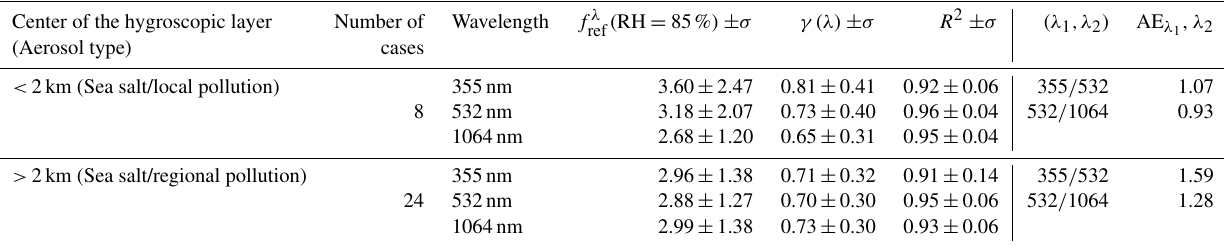
Figure 5. Particle backscatter coefficient enhancement factors with RH ref = 40% at 355, 532, and 1064nm. (a) Spectral Hänel fits for the cases below 2km at 355, 532, and 1064nm; (b) individual f 355 and mean Hänel fit; (c) individual f 532 and mean Hänel fit; (d) individual ref ref f 1064 and mean Hänel fit; (e–h) same as (a–d) for the cases above 2km. The shaded areas around the mean Hänel fits represent the standard ref deviation of all individual fits. at RH = 85% and RH ref = 40%. Mean and standard deviation ( σ ) of γ ( λ ) and the correlation Table 2. Spectral enhancement factor f λ ref coefficient, R 2 . Results are given separately for hygroscopic layers (the layers where hygroscopic growth was calculated) below and above 2km. The layer-mean Ångström exponent between the pairs (355, 532nm) and (532, 1064nm) is reported in the last two columns. Center of the hygroscopic layer Number